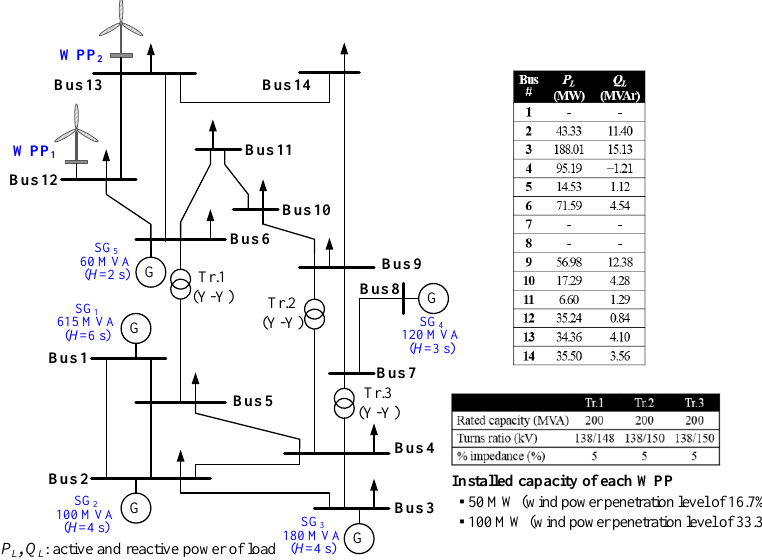
Figure 5. IEEE 14-bus system with two wind power plants (WPPs).